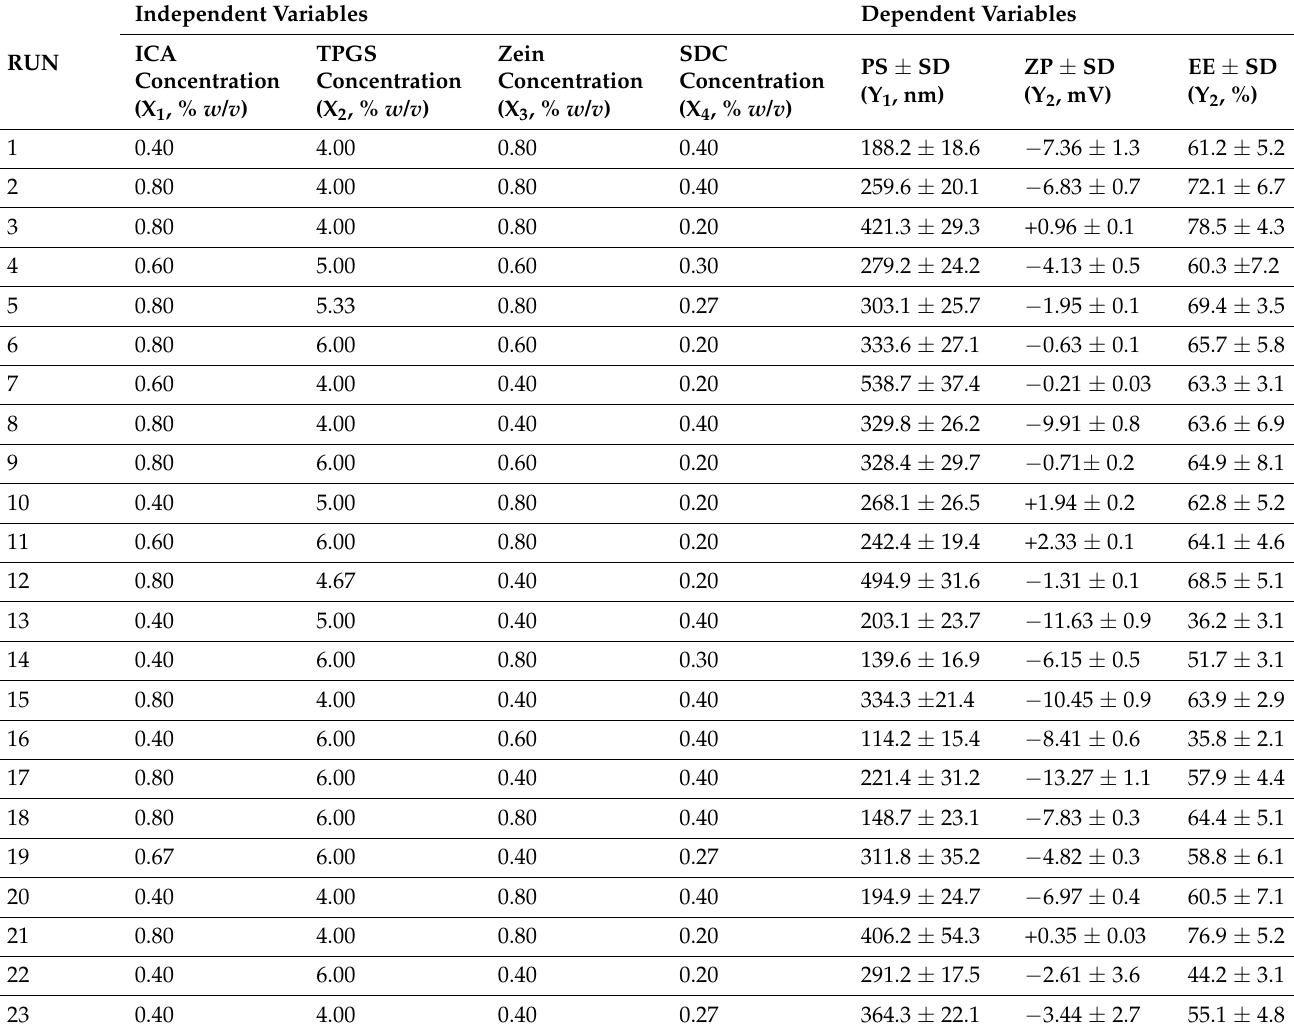
Table 2. Combination of independent variable levels in ICA–tocozeinolate nanosphere experimental runs and their corresponding